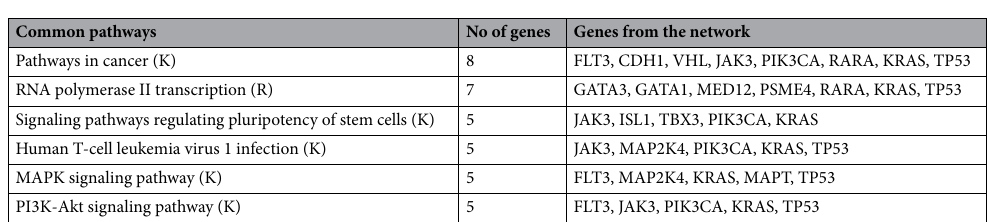
Table 6. Reactome FI analysis for the gene network displayed in Fig. 8.